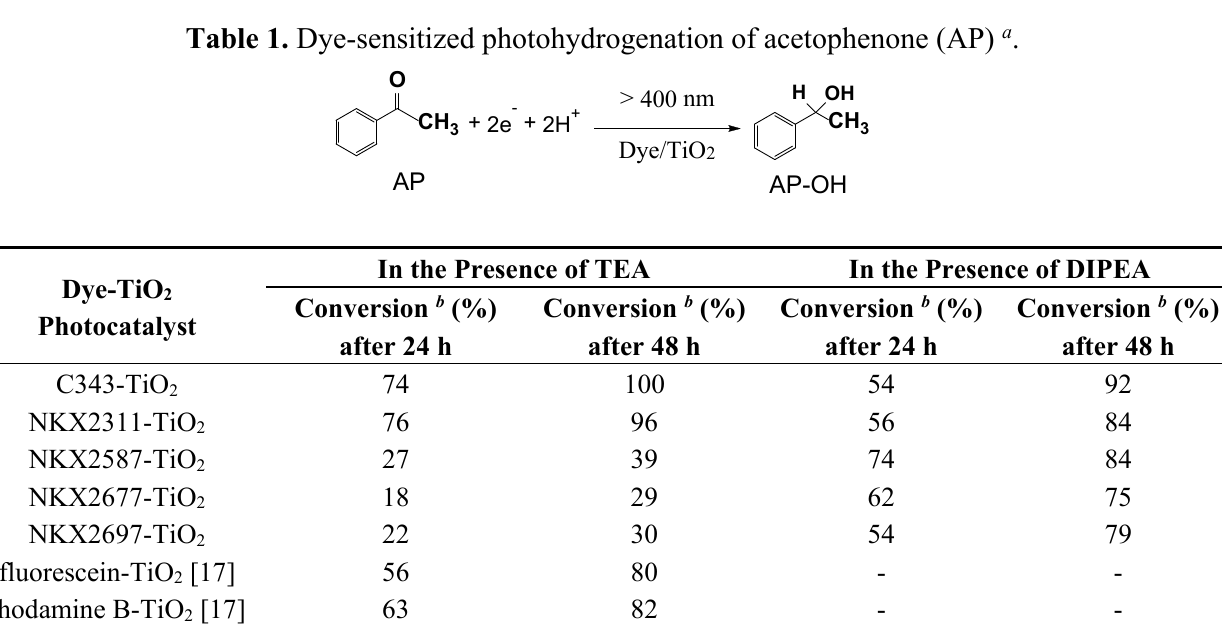
Table 1. Dye-sensitized photohydrogenation of acetophenone (AP) a .